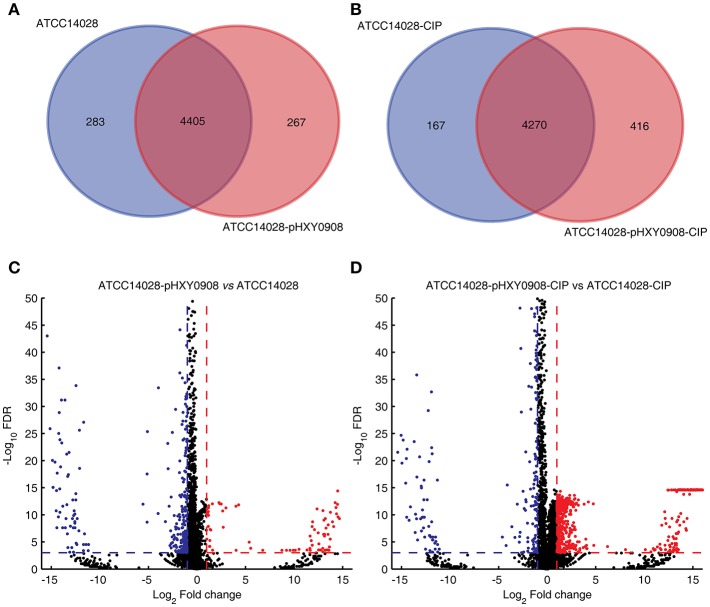
Venn diagram of expressed genes and volcano plot. (A) Venn diagram of expressed genes in ATCC14028 and ATCC14028-pHXY0908. (B) Venn diagram of expressed genes in ATCC14028-CIP and ATCC14028-pHXY0908-CIP. (C) Volcano plot of ATCC14028-pHXY0908 vs. ATCC14028. (D) Volcano plot of ATCC14028-pHXY0908-CIP vs. ATCC14028-CIP. The blue plot in volcano plot represented down-regulated genes (Log2 Fold change ≤ −1 and FDR <0.001). The red plot in volcano plot represented up-regulated genes (Log2 Fold change ≥ 1 and FDR <0.001).